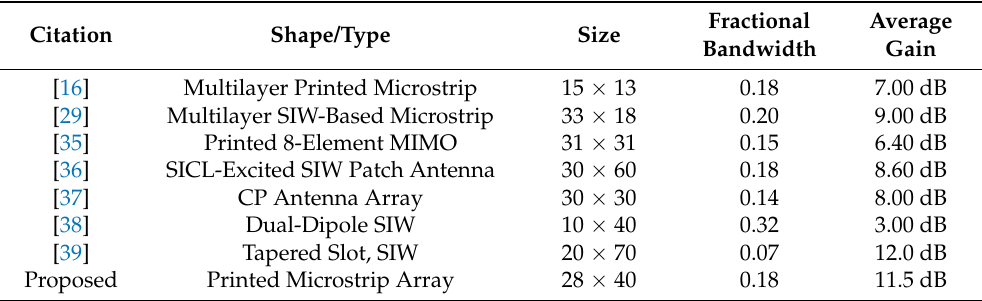
Table 4. Gain and efficiency of the proposed array antenna at different